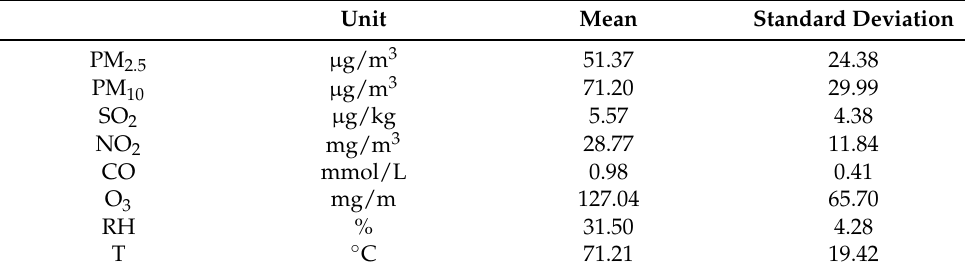
Table 1. Descriptive statistics of pollutants and meteorological